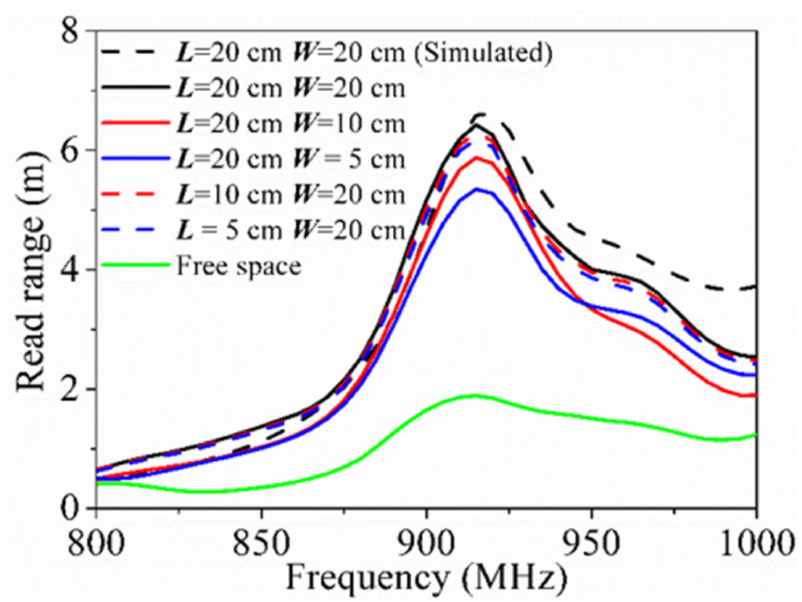
Figure 12. Simulated read range of the tag on a 20 × 20 cm 2 copper plate, measured read ranges of the tag on copper plates of different sizes and measured read range of the tag in free